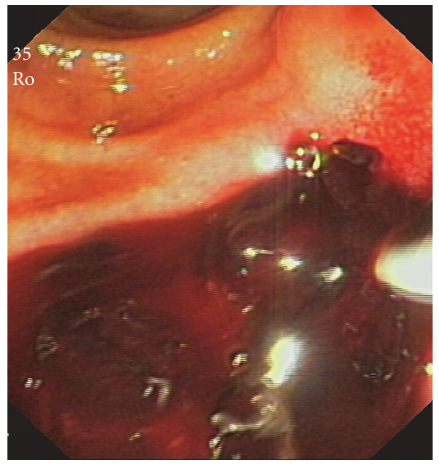
Figure 2: Severe bleeding from the sphincterotomy site.